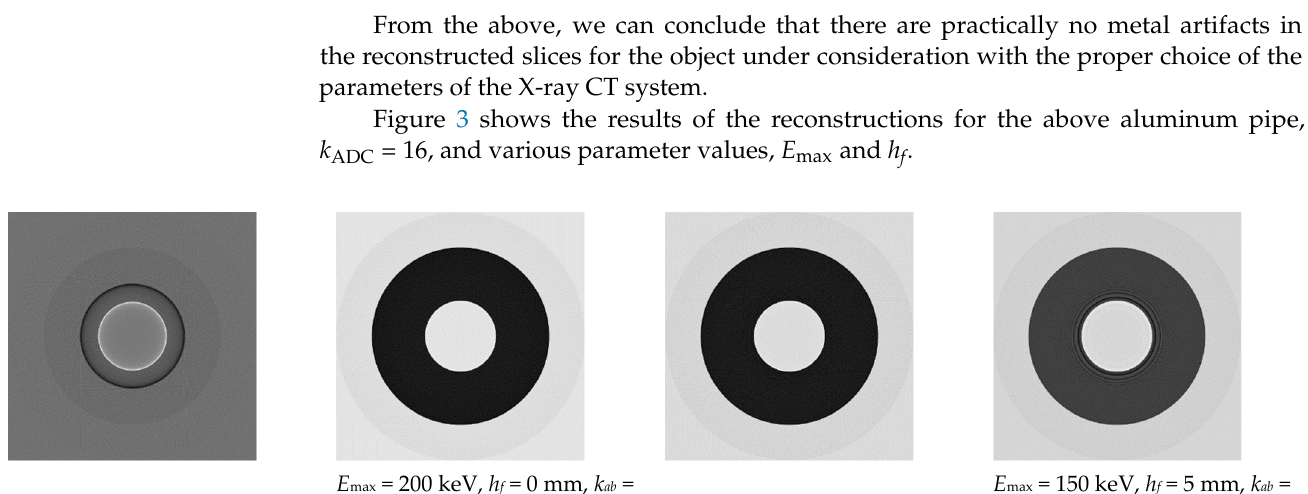
Figure 2. Reconstructed slices of an aluminum cylinder with a diameter of 250 mm.